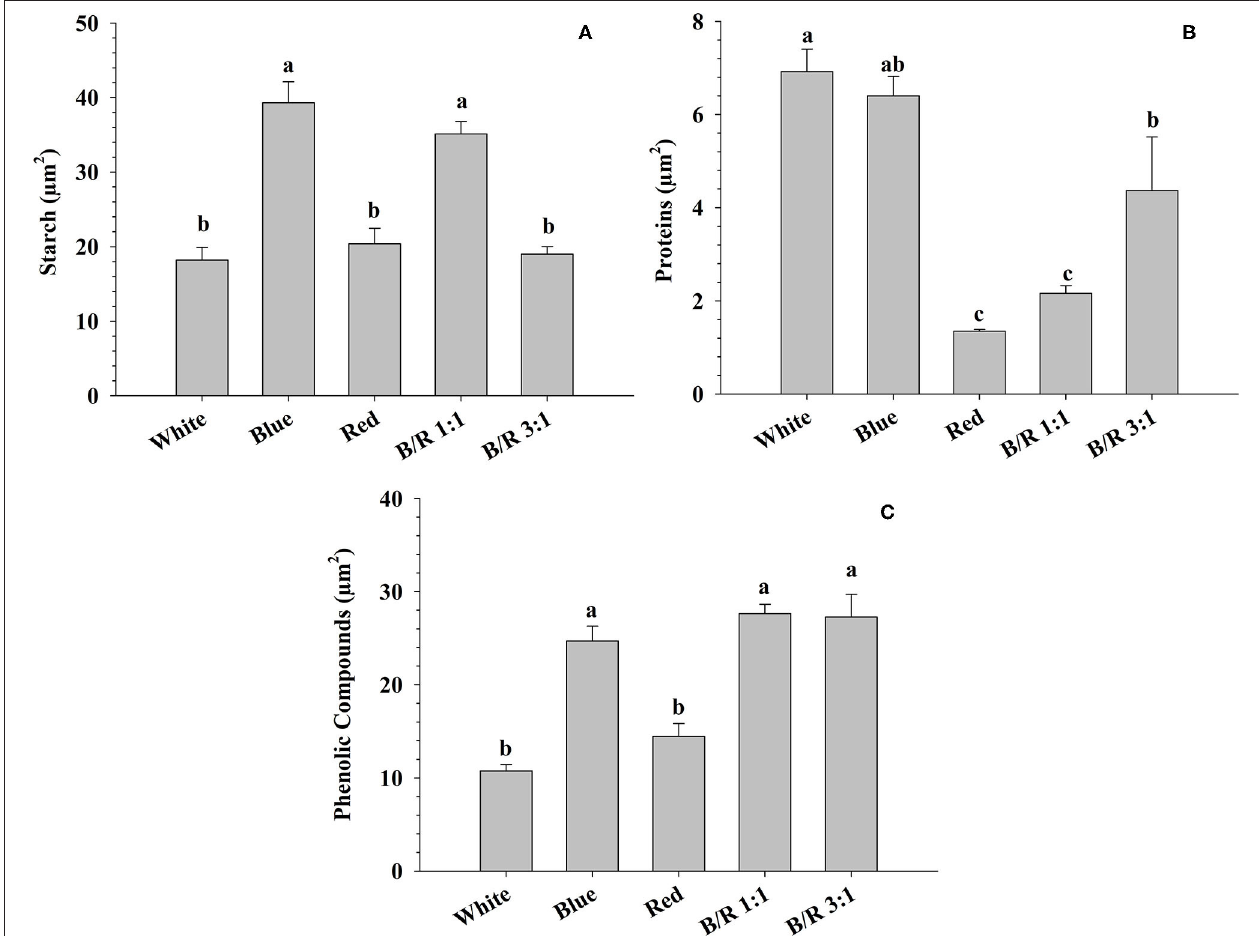
FIGURE 7 | Accumulation of starch, protein, and phenolic compounds in leaf tissues of Brosimum gaudichaudii grown in vitro under different LED spectra for 50 days. (A) Starch ( µ m 2 ), (B) protein ( µ m 2 ), and (C) phenolic compounds ( µ m 2 ). Means followed by the same letter do not differ according to Tukey’s test at 5% probability. The values are presented as the mean ± standard error ( n =